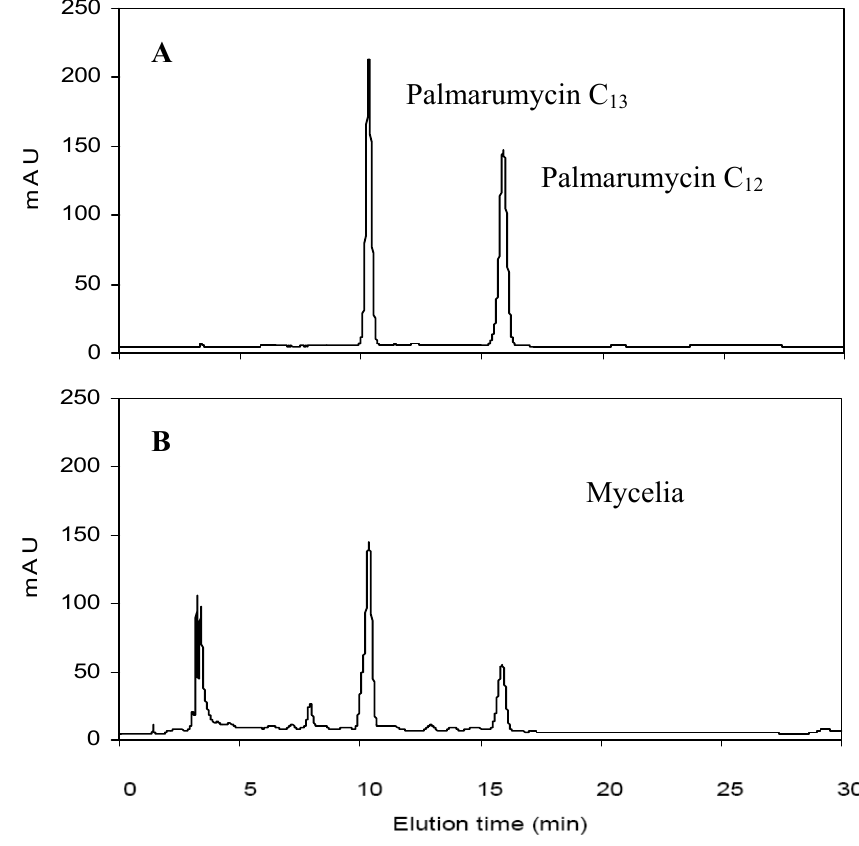
Figure 1. HPLC profiles of the extracts of mycelia and broth for palmarumycins C analysis: palmarumycins C and C ( A ), mycelia extract from batch culture on day 13 C 13 12 13 ( B ), broth extract from batch culture on day 13 ( C ). Elution time (retention time) for palmarumycins C and C were 15.911 min and 10.326 min, respectively. Palmarumycin 12 13 was undetectable in the broth C 12